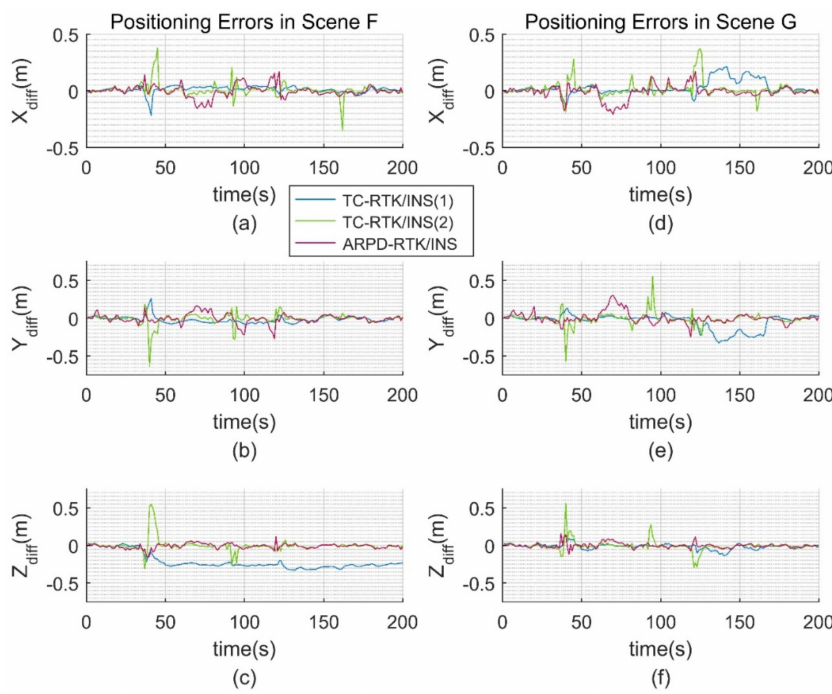
Figure 16. ( a ) Error distribution in the ECEF-X axis for Scene F; ( b ) Error distribution in the ECEF-Y axis for Scene F; ( c ) Error distribution in the ECEF-Z axis for Scene F; ( d ) Error distribution in the ECEF-X axis for Scene G; ( e ) Error distribution in the ECEF-Y axis for Scene G; ( f ) Error distribution in the ECEF-Z axis for Scene G.